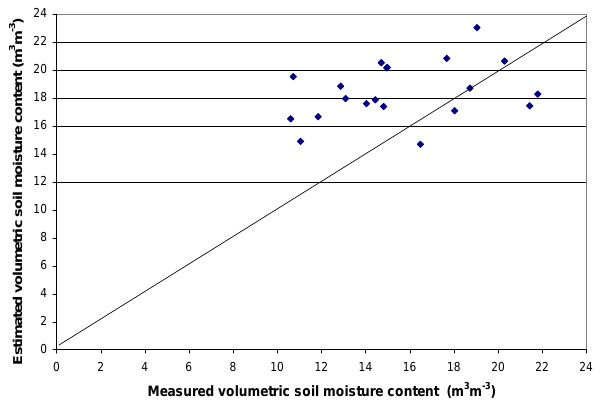
Fig. 4. Scatter plot of volumetric soil moisture contentmeasured and estimated by OM.